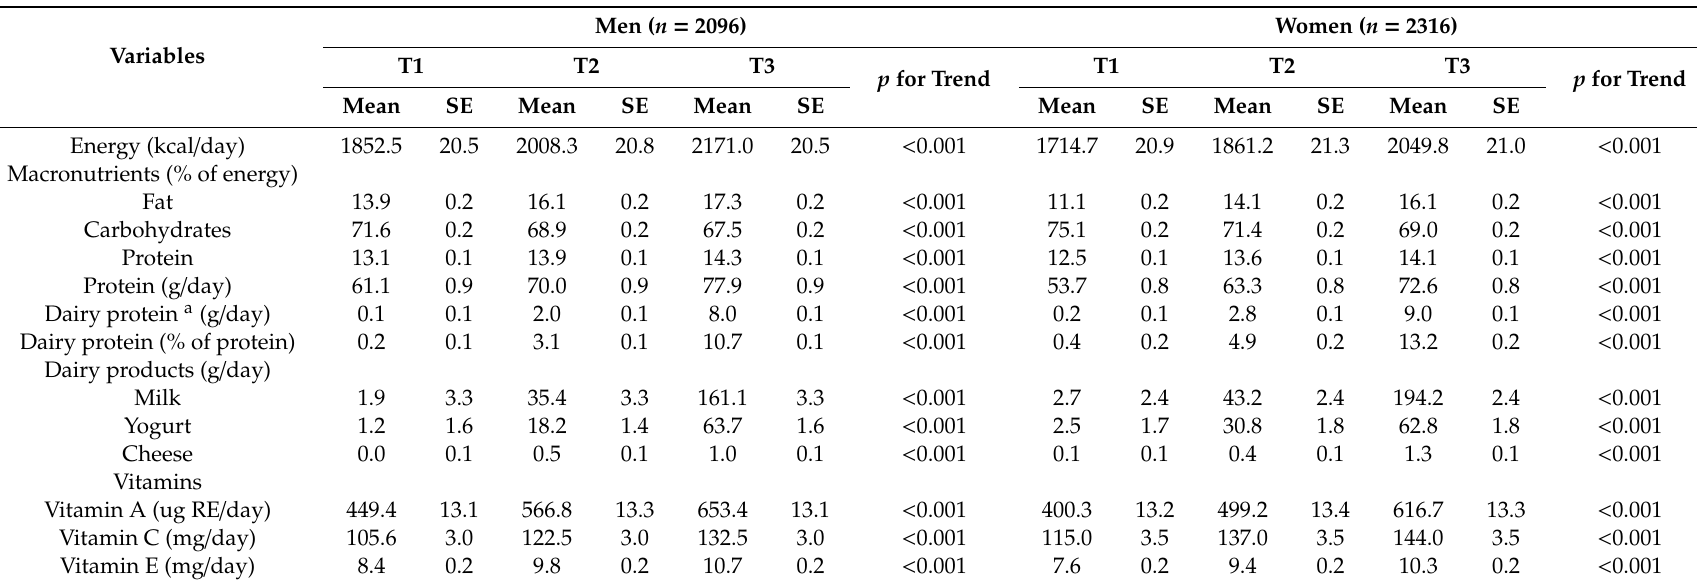
Table 2. Nutrient intakes of the study participants according to tertiles of dairy protein intake at